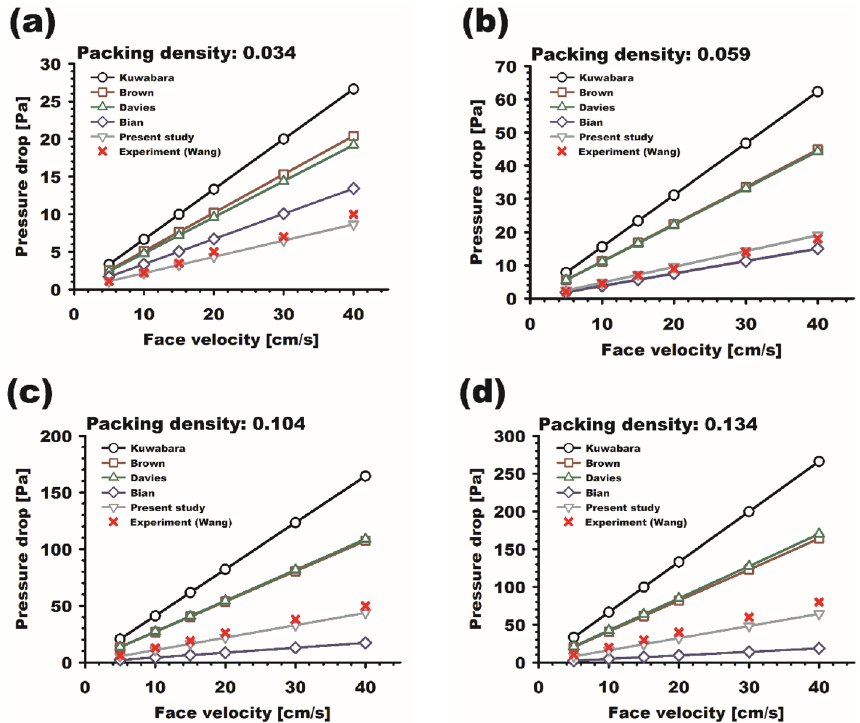
Figure 10. Comparison between pressure drops obtained by theoretical approaches, empirical correlations, present model, and experiments for ultra-thin single-layer nanofiber filters with different packing densities of ( a ) 0.034, ( b ) 0.059, ( c ) 0.104, and ( d ) 0.134 as a function of face